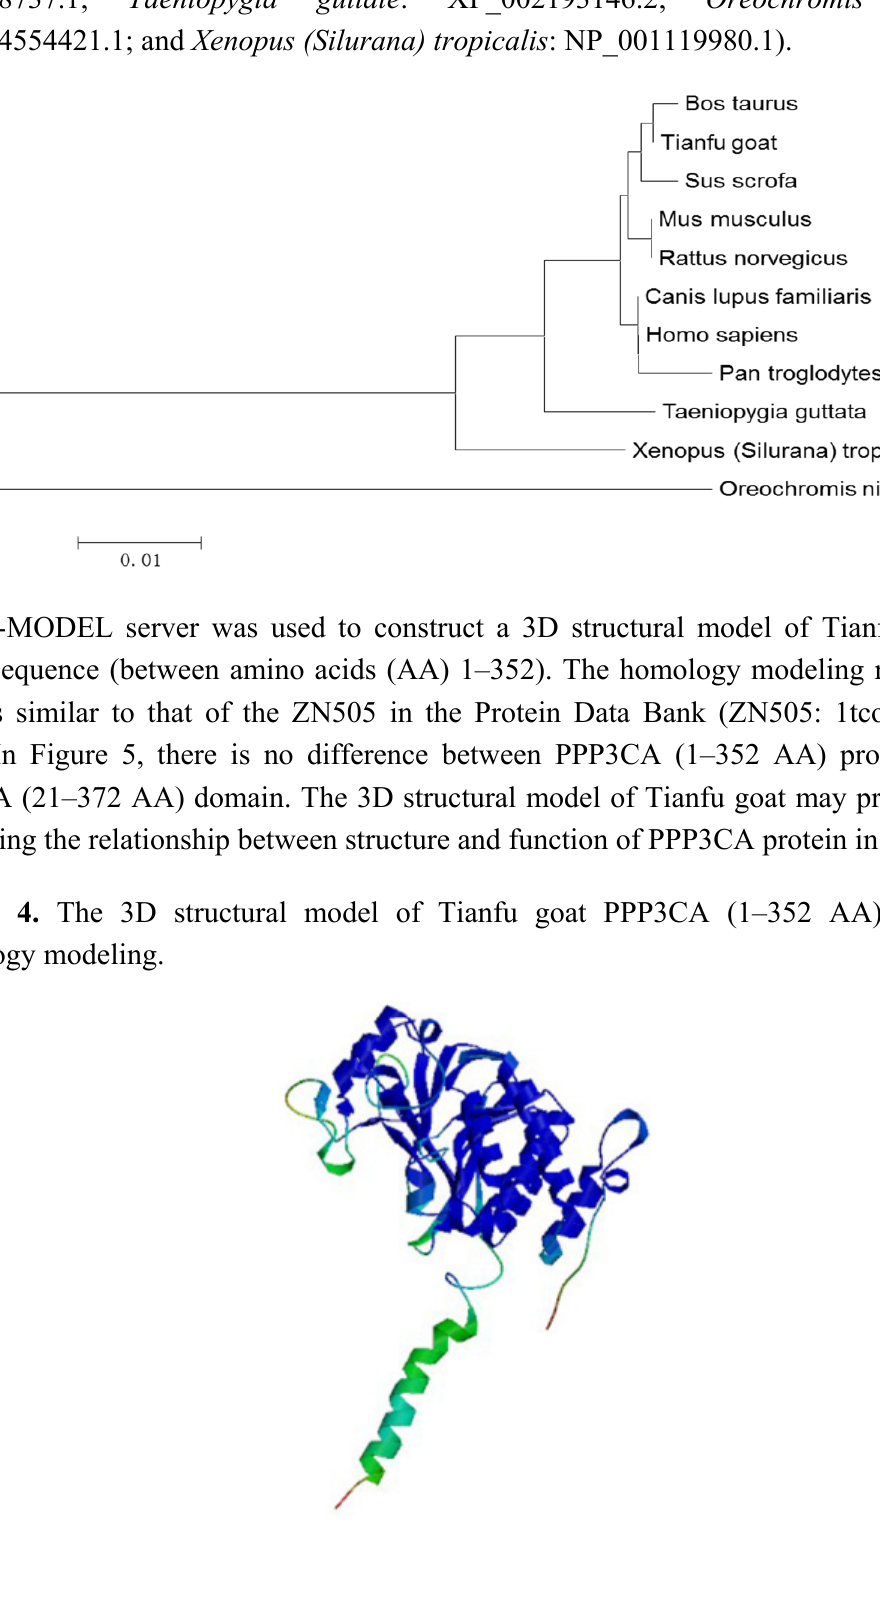
Figure 3. Phylogenetic tree of the amino acid sequences of PPP3CA. The tree was constructed using the Neighbor Joining method in the MEGA 5.10 software. All above sequences are from the NCBI data base ( Bos mutus : NP_777212.1; Sus scrofa :